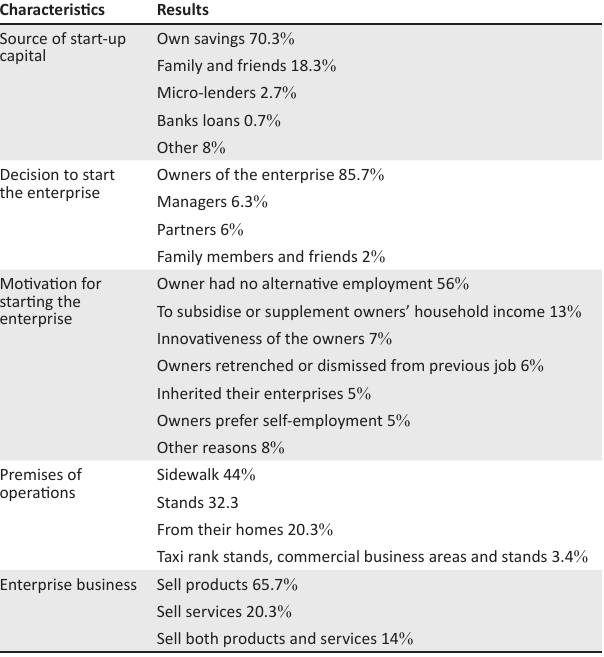
TABLE 4: Enterprise characteristics ( n =